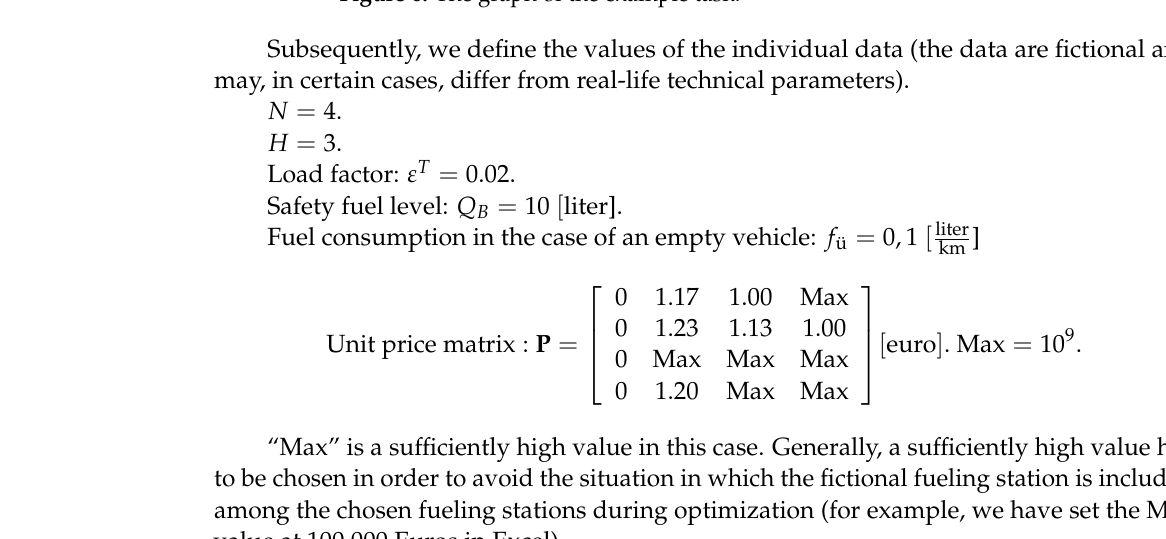
Figure 6. The graph of the example